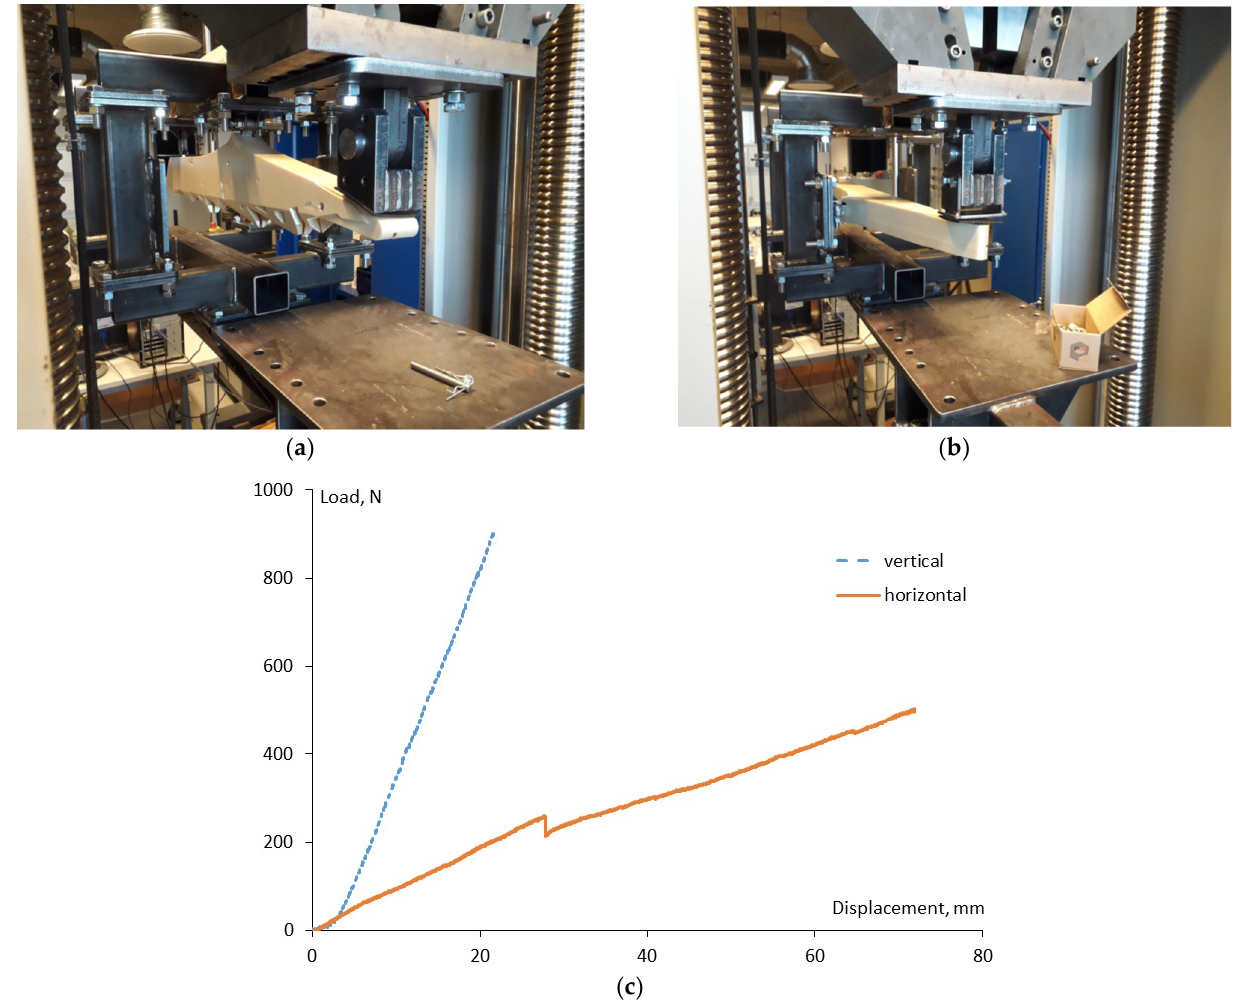
Figure 10. 3D-printed class divider during mechanical testing in vertical pull downward ( a ) and horizontal push forward ( b ), and associated load-displacement curves for the load conditions indicated on the graph ( c ).